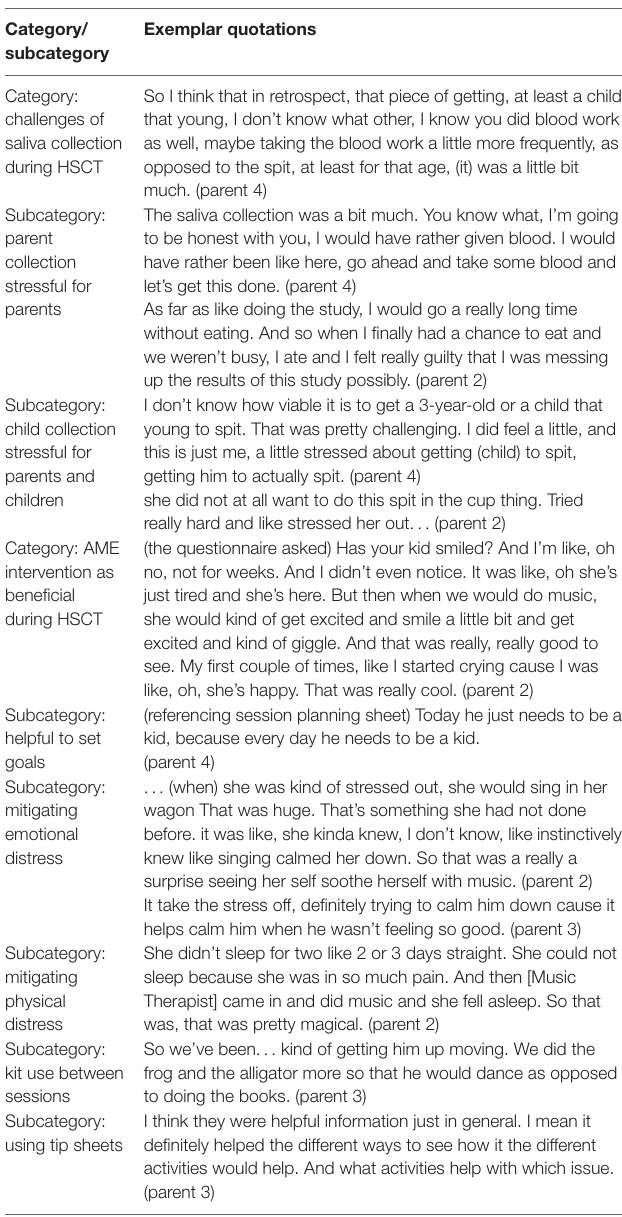
TABLE 3 | Categories, subcategories, and exemplar quotations for semi-structured